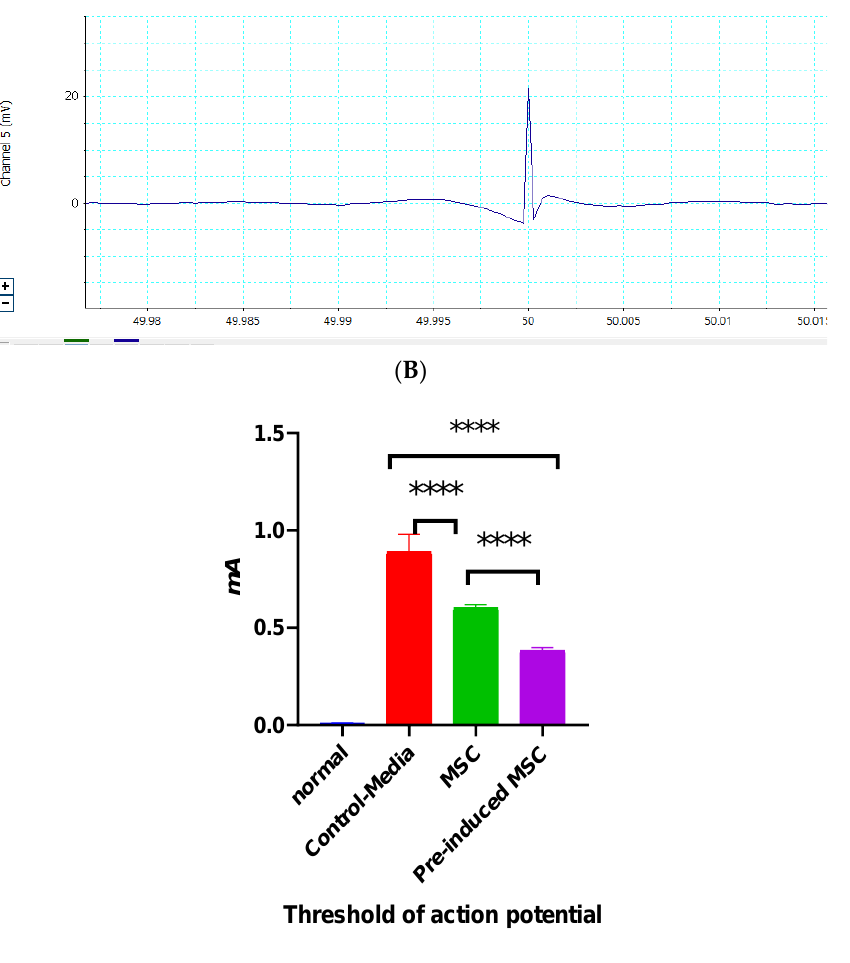
Figure 6. Measurement of threshold of action potential ( A ). The graph of action potential in the lab chart of PowerLab ( B ). The threshold of action potential of each group was compared to normal nerve. Pre-induced MSC coated cellulose/collagen nanofibrous conduit group showed significantly reduced than other groups. One way ANOVA between group, p < 0.0001. Values of **** p < 0.0001 were considered statistically significant ( C ).